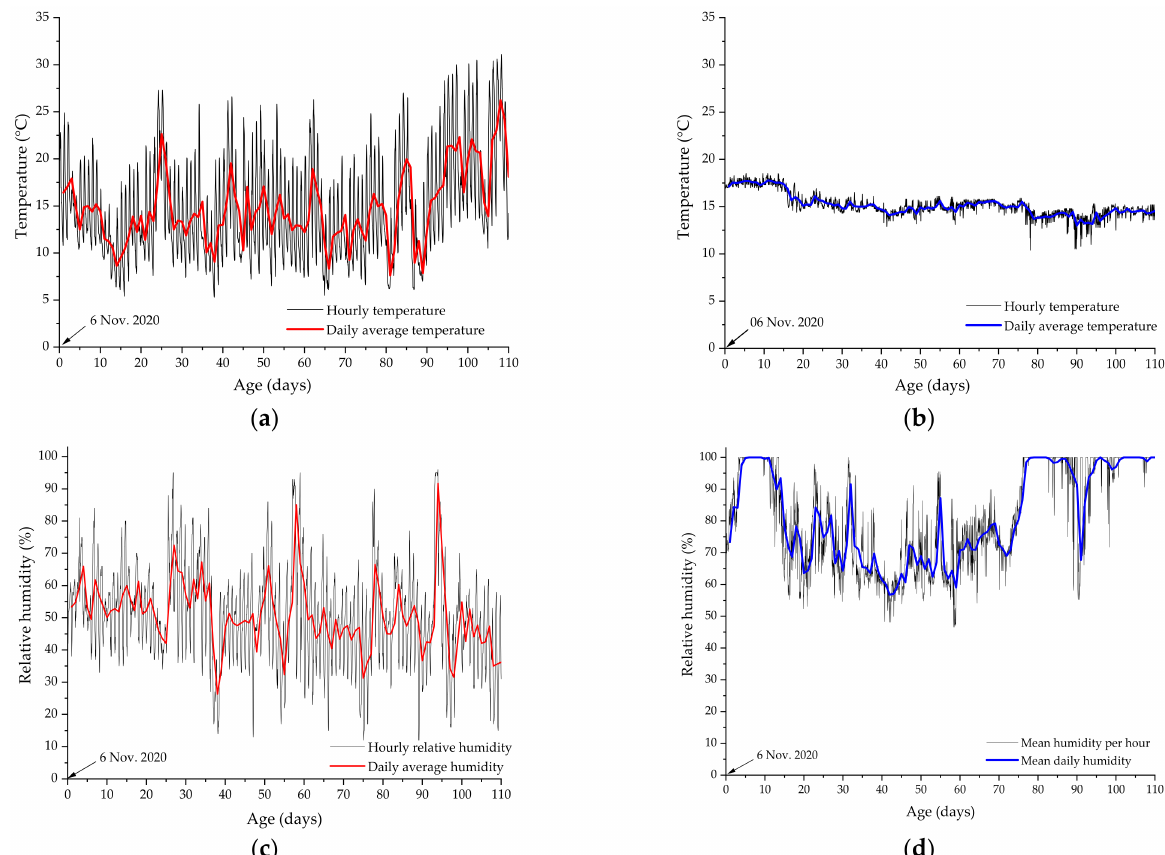
Figure 17. The variation of temperature and humidity inside and outside the gallery: ( a ) hourly and daily average temperature outside the gallery; ( b ) hourly and daily average temperature inside the gallery; ( c ) hourly and daily average humidity outside the gallery and ( d ) hourly and daily average humidity inside the